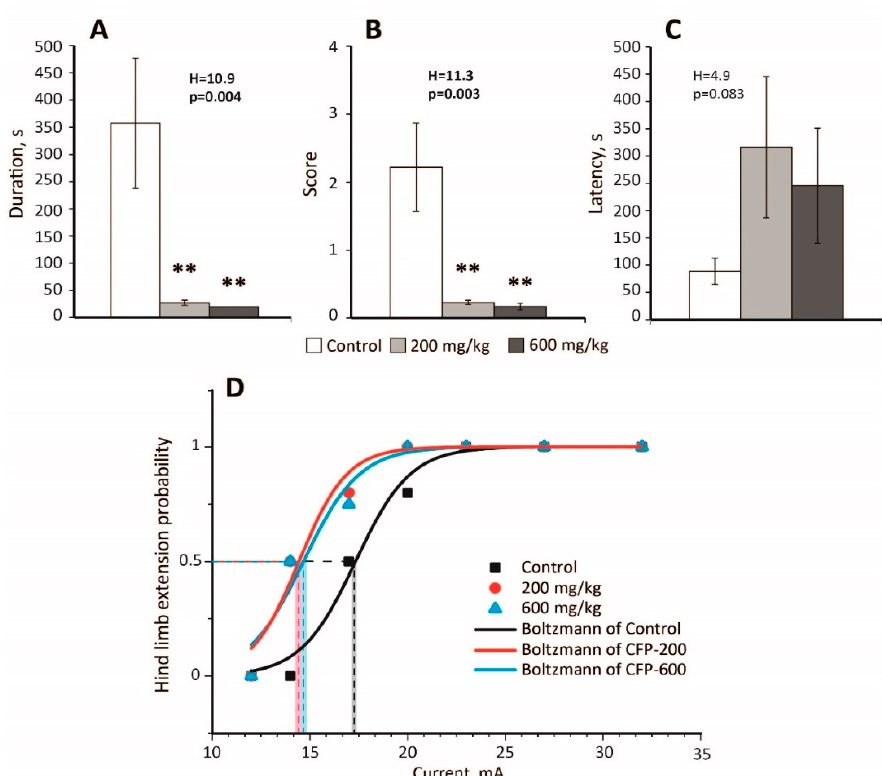
Figure 1. An anticonvulsant e ff ect of cefepime (CFP) in the pentylenetetrazole (PTZ) model ( A – C ) and a proconvulsant e ff ect of CFP in the maximal electroshock threshold (MEST) test ( D ). ( A ) The duration, ( B ) the mean score of severity, ( C ) the latency of PTZ-induced convulsions. H—Kruskal–Wallis one-way analysis of variance. **—significant di ff erences from the control group ( p < 0.01) according to the Mann–Whitney U test, which was used for post hoc comparisons. ( D ) Hind limb extension probability in the MEST test. Experimental results are approximated with Equation (1), and the corresponding EC 50 values are marked with dashed lines; shadow represents the standard error of parameter estimates.